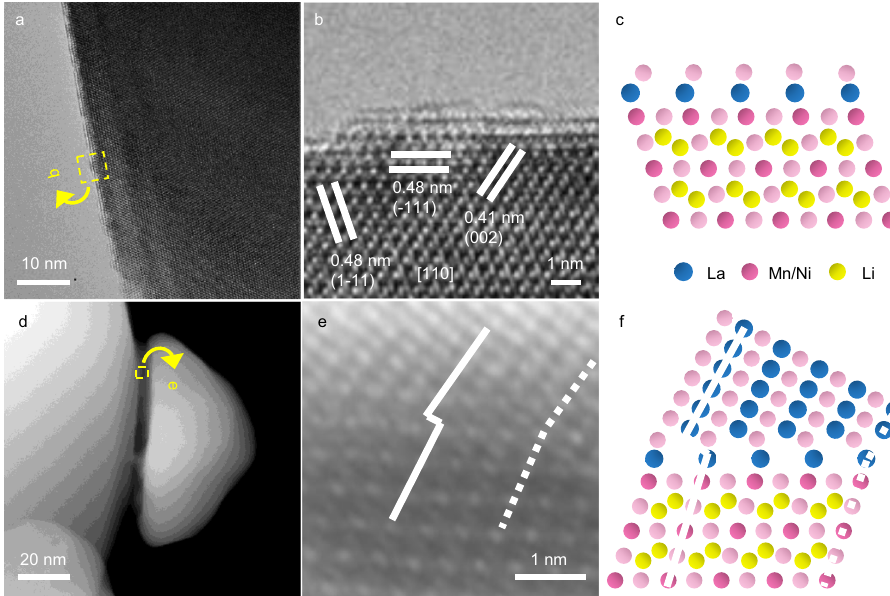
Fig. 4 TEM analysis on the LNMO-LaTMO 3 heterostructure. a HR-TEM image captured at the edge of LNMO-C0.5La from [110] axis. b Zoom on the marked region in ( a ) (rotated). c Predicted structural model of LNMO-C0.5La. d HAADF-STEM image taken at the boundary between the spinel and the La-rich surface island. e Zoom (rotated) on the interface showing interface defects (full vertical lines) and coincidences (dashed vertical lines). f The associated structural model of the LNMO-LaTMO 3